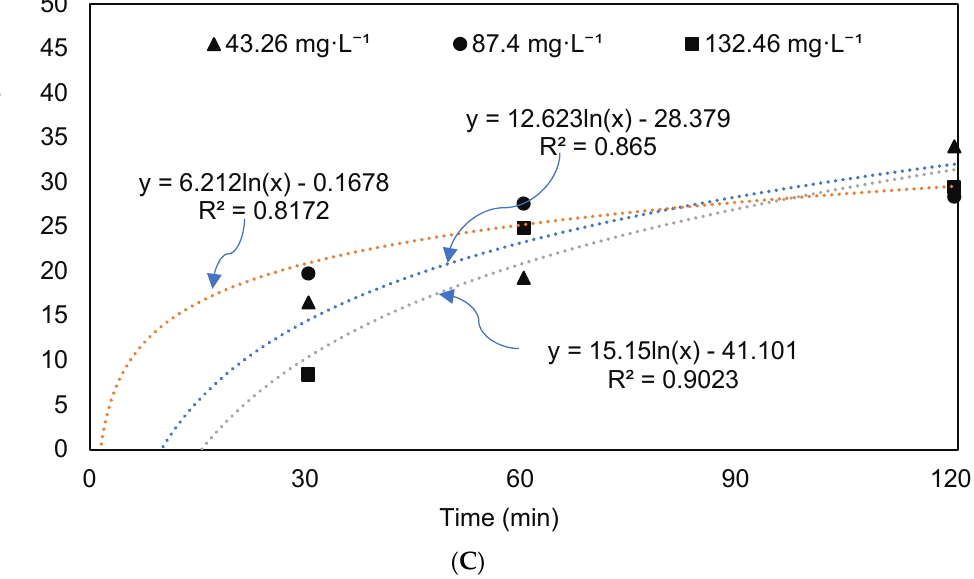
Figure 2. Change in E. coli levels: ( A ) E. coli O157:H7 counts; ( B , C ) reduction percentages in the dairy manure with E. coli inoculation ( B ) or without E. coli inoculation ( C ) under different ozone concentrations and durations (note: the letters above columns showed the differences among different lasting times, which was the same as the next figures; means denoted by a different letter indicate significant differences between treatments ( p < 0.05)).